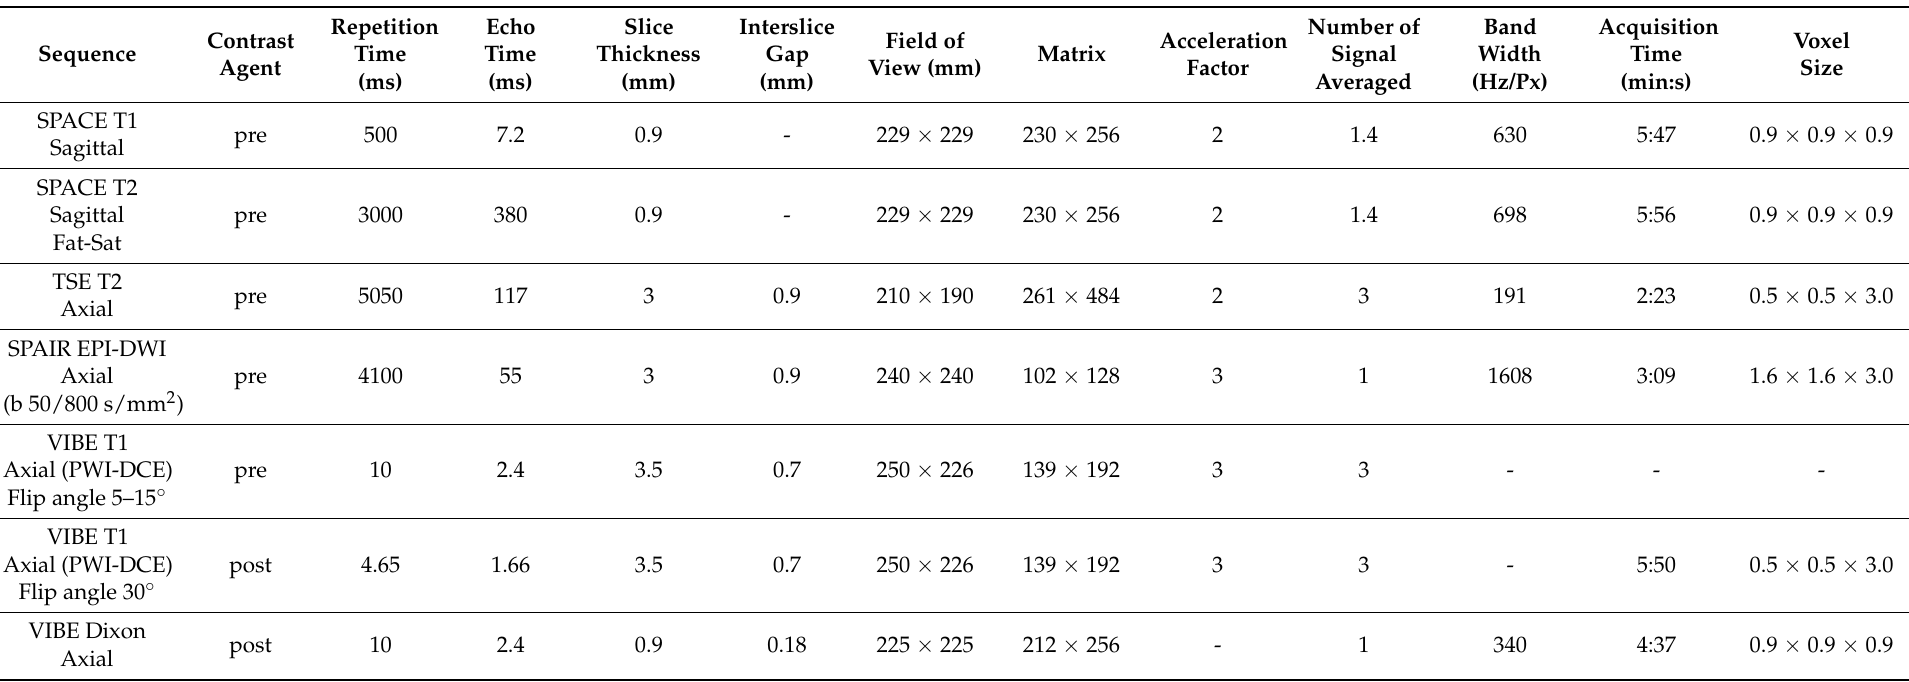
Table 3. Parameters for oral cavity standard acquisitions performed with 1.5 T Magnetom Aera (Siemens Healthcare, Erlangen,